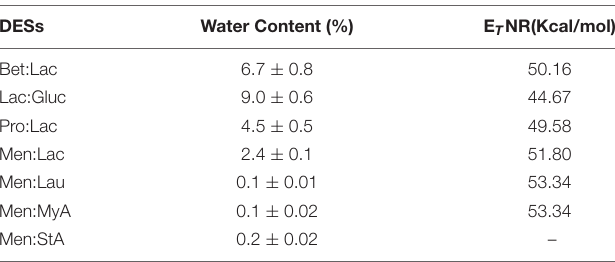
TABLE 2 | Experimental water content (%) and polarity (E T NR) of the DESs:Betaine lactic acid Bet:Lac (1:2), lactic acid glucose Lac:Gluc (5:1),